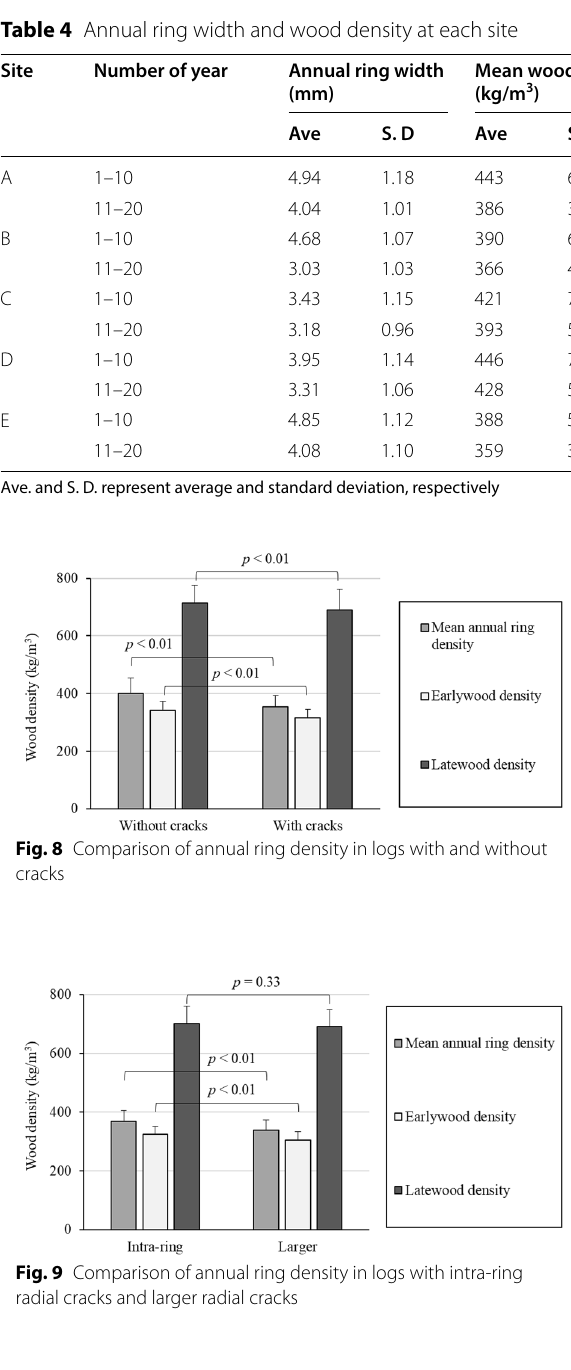
the external environment. Furthermore, the earlywood density of annual rings with larger cracks was lower